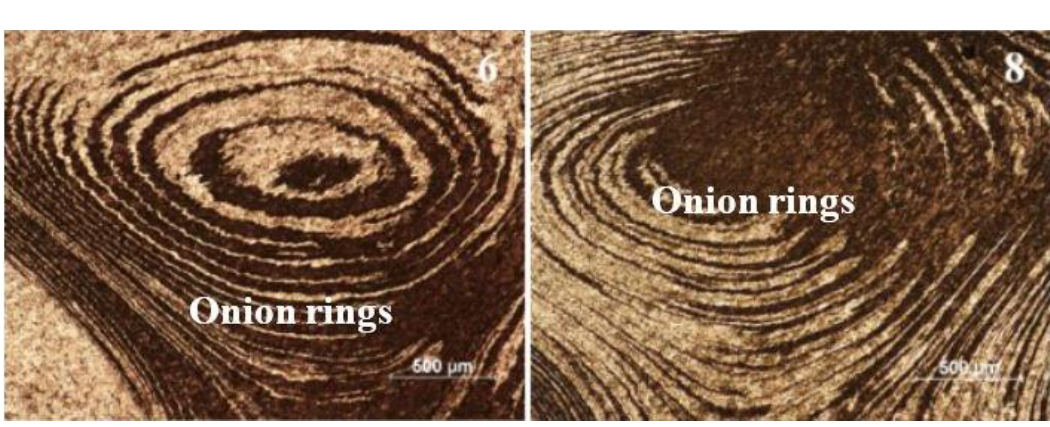
Figure 4. Nugget zone structures consisting of onion rings.